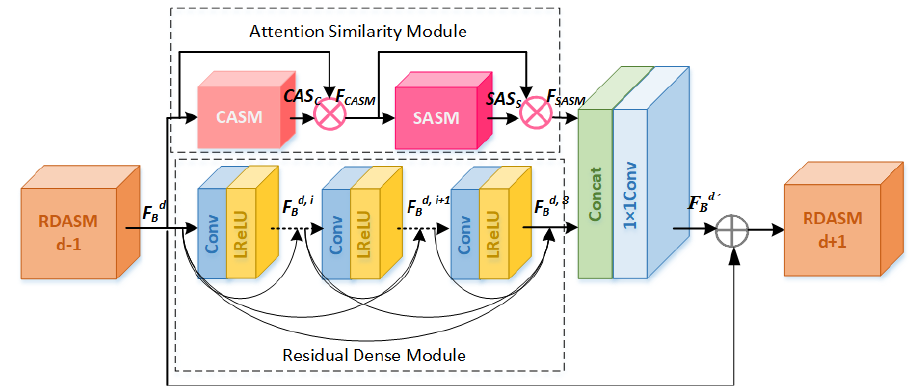
Figure 2. Residual dense attention similarity module. CASM and SASM represent the channel attention similarity module and spatial attention similarity module,